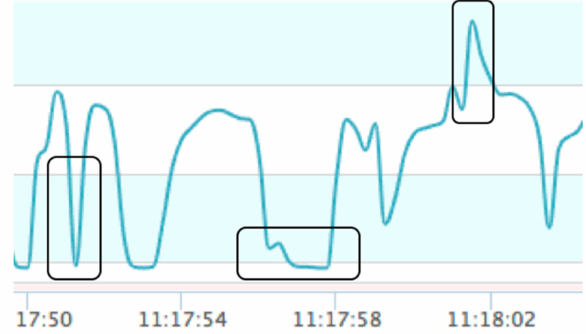
Figure 2. The three types of Non-Specific Skin Conductance Responses (NSCR) peaks assessed in Laboratory Test A: down peak, flat peak and up peak (from left to right in